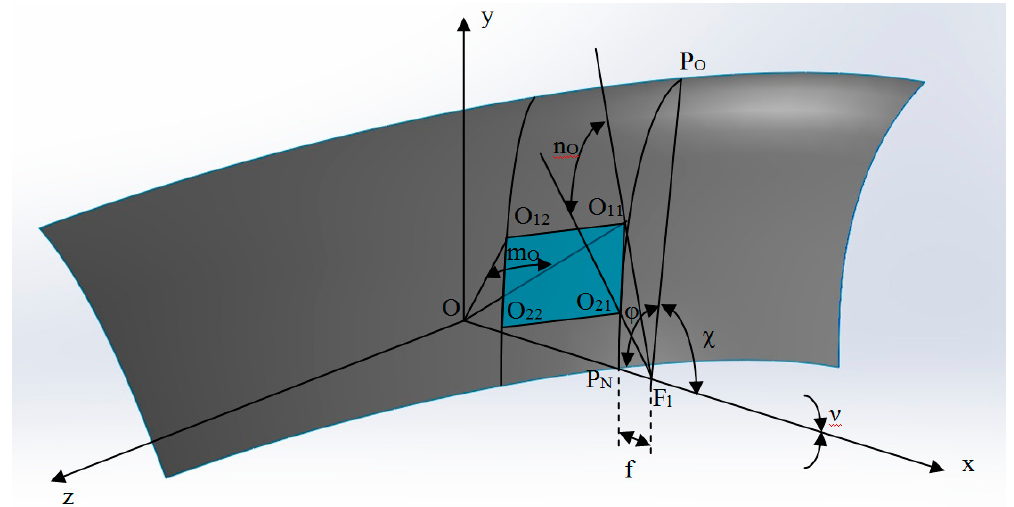
Figure 12. The geometric model of the reflector with the surface constituting a section of the parabolic torus, approximated by a set of finite number of elementary flat surfaces.